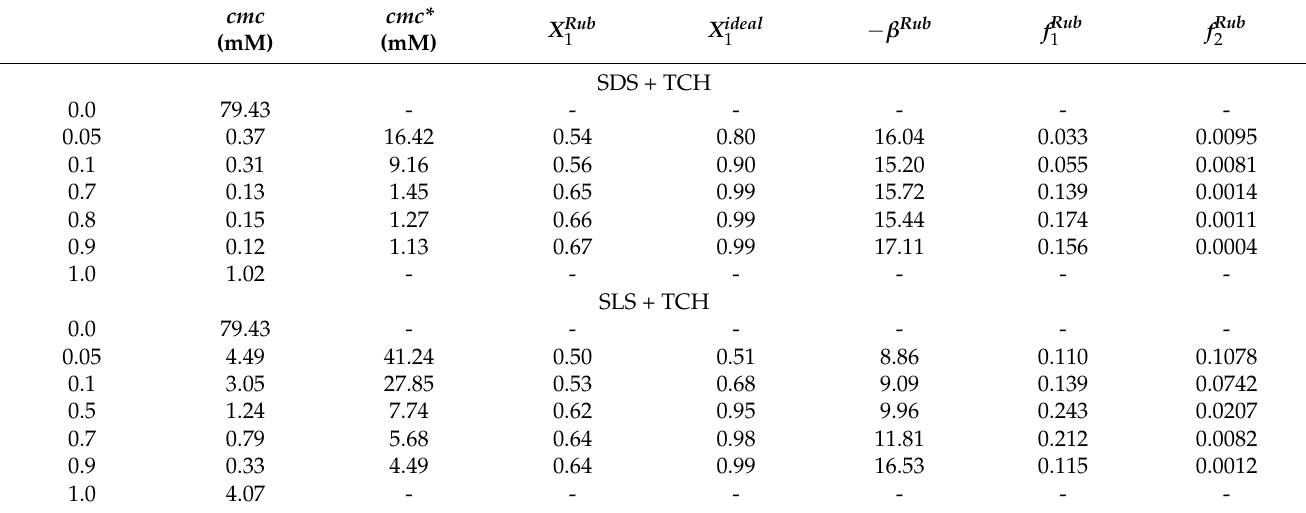
Table 1. Physical parameters of TCH + SDS/SLS mixed systems in aqueous